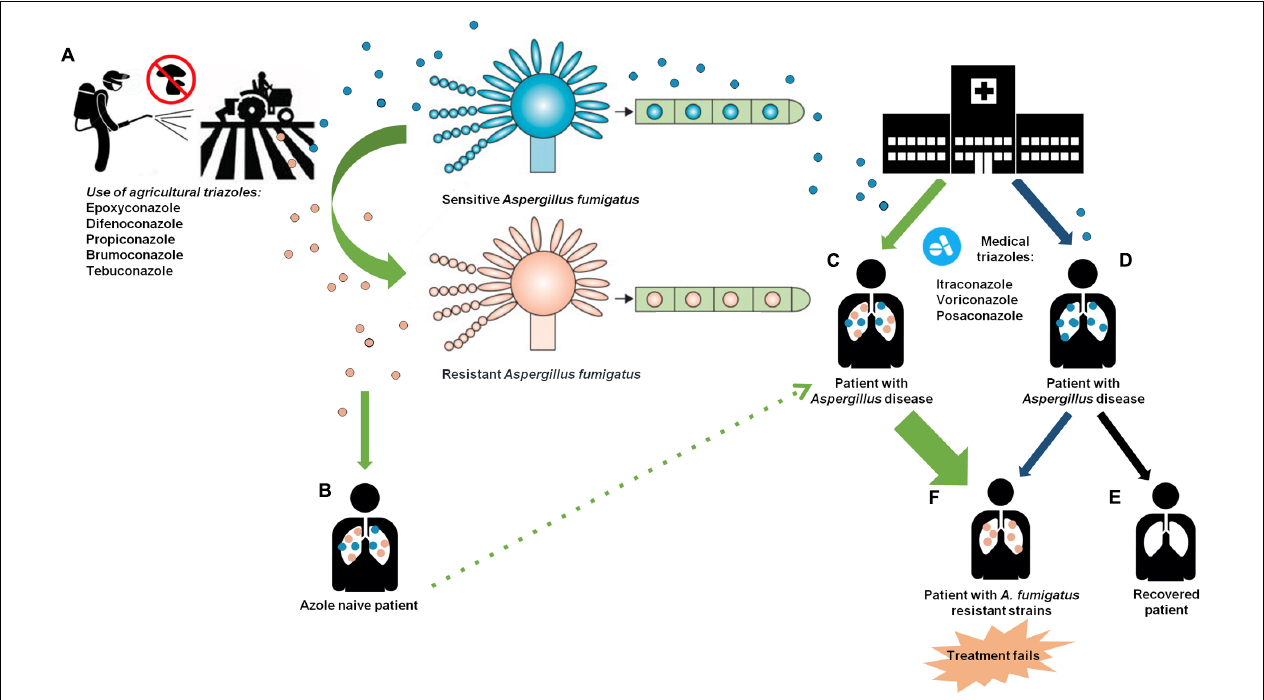
FIGURE 2 | The environmental and clinical routes of azole resistance development. (A) The exposure of A. fumigatus to azole compounds in agriculture may create mutations in conidia inducing a resistant phenotype. (B) Azole naive patient becomes ill upon inhalation of airborne resistant and sensitive A. fumigatus strains. (C) The azole naive patient is treated with medical triazoles creating a persistent pressure of azole leading to the selection of resistant strains. (D) Patients infected by inhaling sensitive A. fumigatus molds receive long-term azole therapy. (E) A small proportion of patient who received long-term azole therapy without developing resistant A. fumigatus strains (black arrow). (F) Patients with A. fumigatus resistant strains that have developed through long-term azole therapy (blue arrow) or by the use of azole in agriculture (green arrow). This induces a failure in the management of Aspergillus diseases. Adapted from Verweij et al.